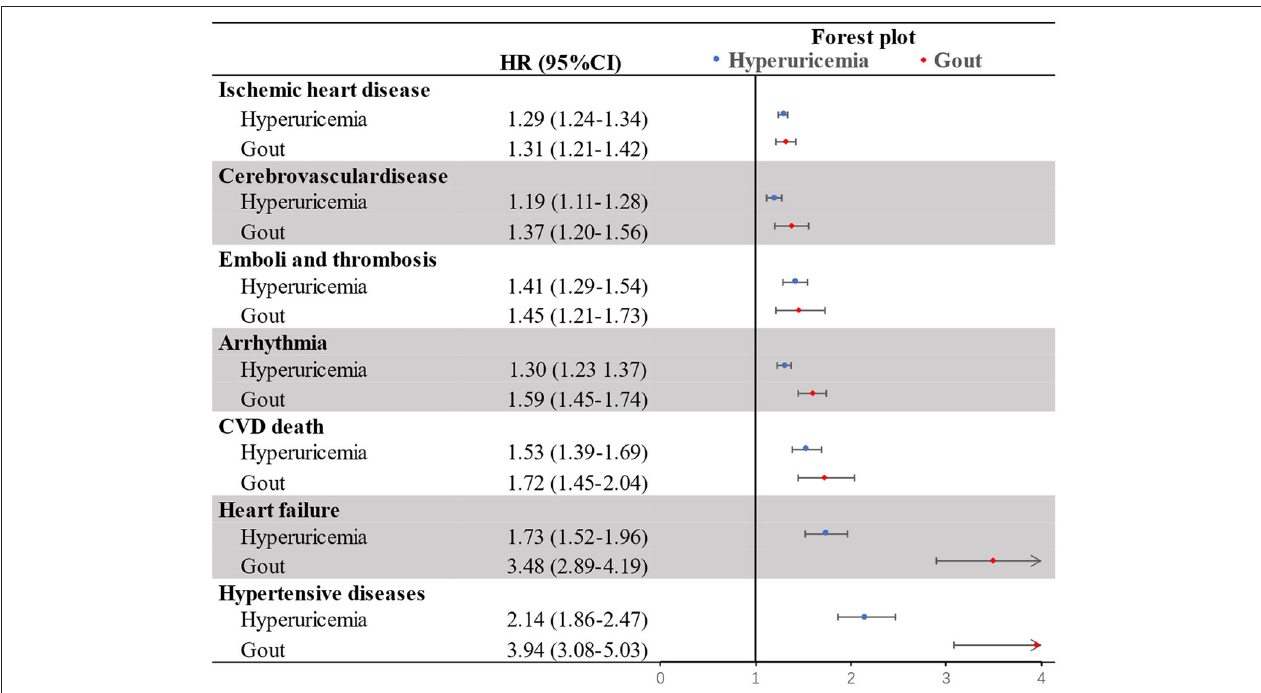
FIGURE 2 | Hazard ratios of specific cardiovascular diseases (CVDs) among patients with studied hyperuricemia or gout when compared with patients without hyperuricemia and gout.